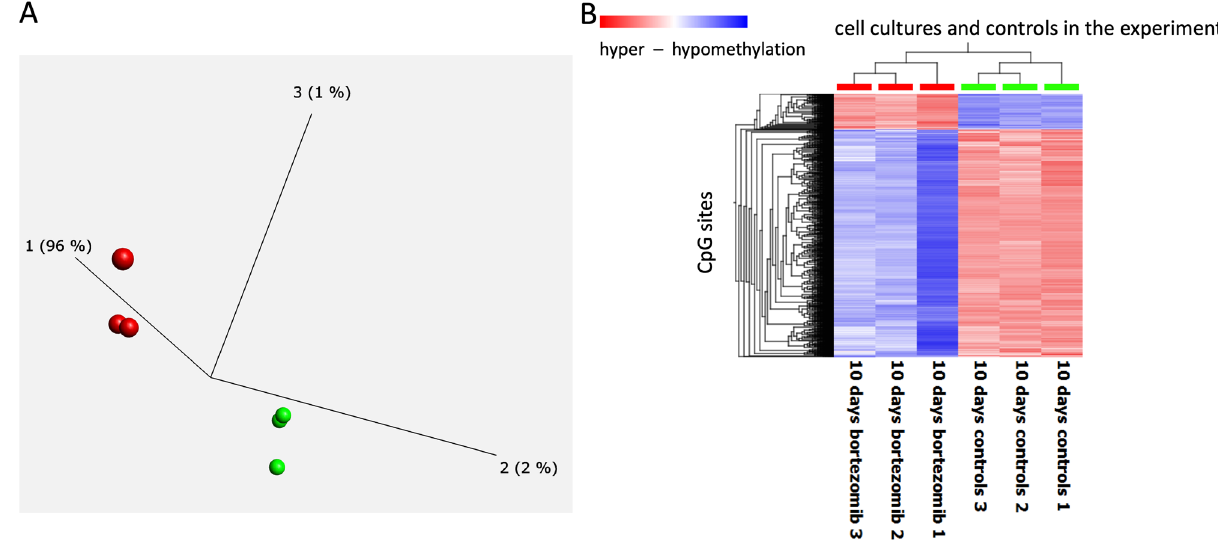
Figure 2. PCA (Principle Component Analyses)—( A ) and heatmap—( B ), illustrating results of genome wide methylation changes in cells under treatment and controls. PCA indicates three replicates of genome wide methylation profiles of cells recovered after BTZ treatment after 10 days (red color) have significantly different methylation profile than controls (green color). Heatmap illustrating unsupervised clustering analyses of methylation changes at the most informative CpG sites in the data set verifies PCA analyses with cells recovered after BTZ treatment (red color top of chart) displaying significant hypomethylation (blue color in the heatmap) and a degree of hypermethylation (red color in the heatmap) in comparison to controls (green, top of